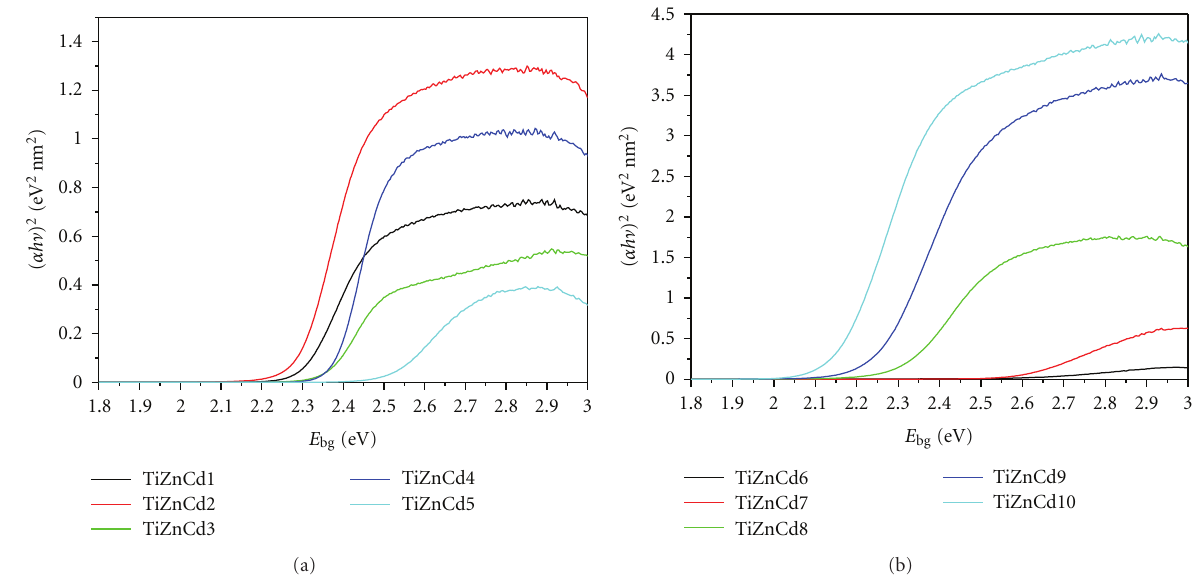
Figure 9: Band-gap energy E bg of prepared TiZnCd